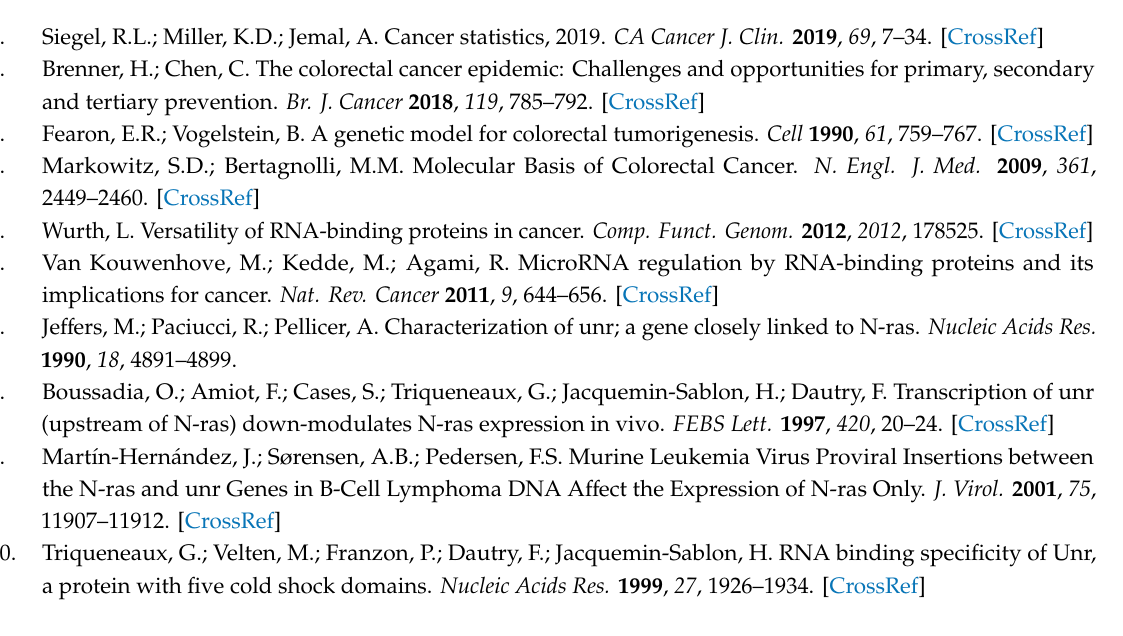
Figure S1. ROC curve of the analyzed training set according to UNR Hscore. (A) Table containing ROC curve estimation parameters. AUC: area under the curve. (B) ROC curve performed with UNR